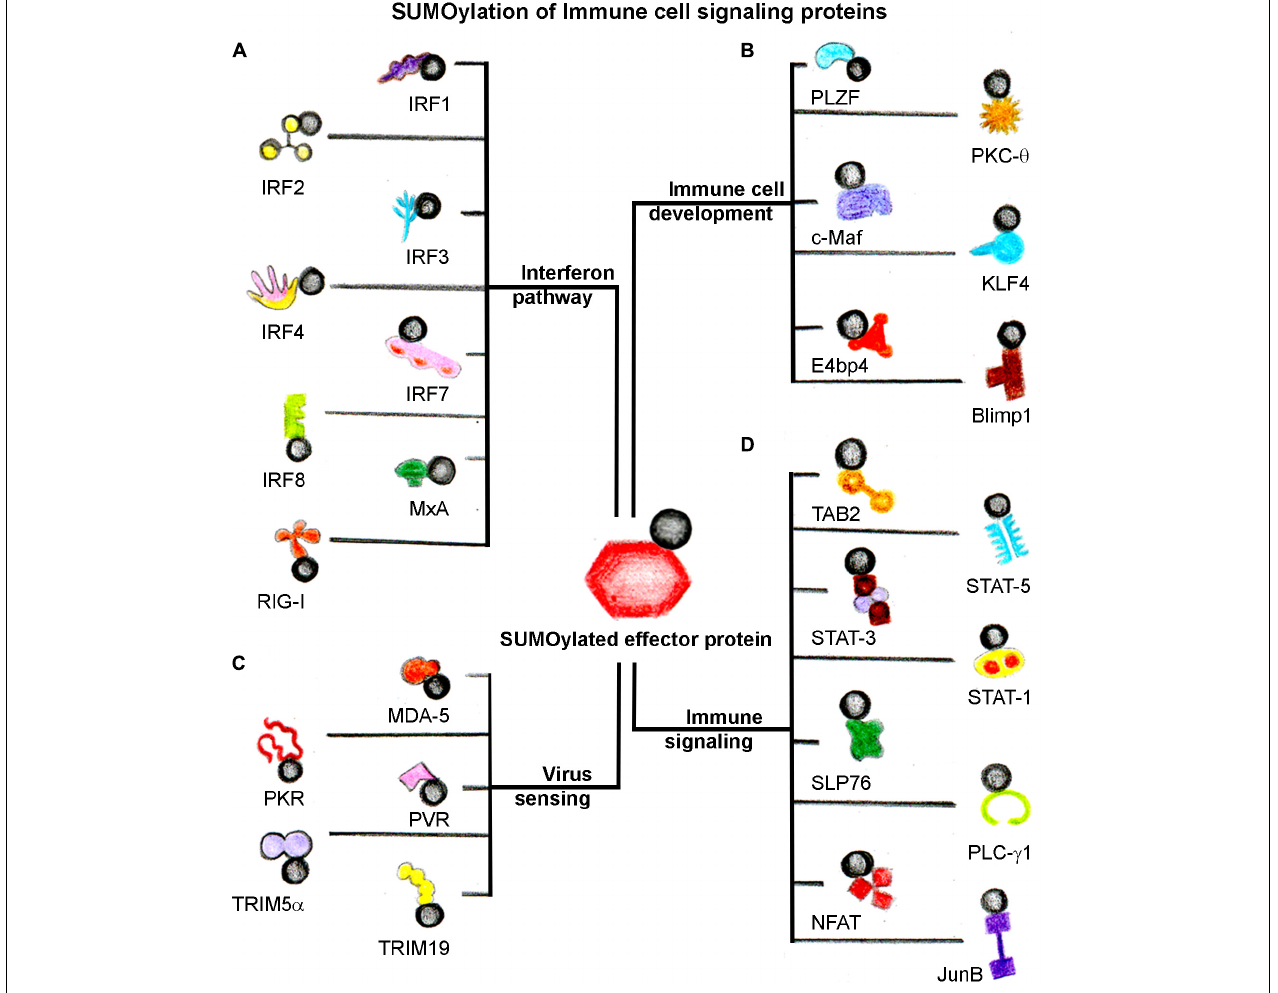
FIGURE 3 | SUMOylation of host immune signaling proteins. SUMOylation dynamics of several host immune cell proteins alter in response to infection. A general categorization of SUMOylated target host proteins involved directly in (A) Interferon signaling, (B) Immune cell development, (C) Virus sensing, and (D) Immune signaling events. The black circle represents